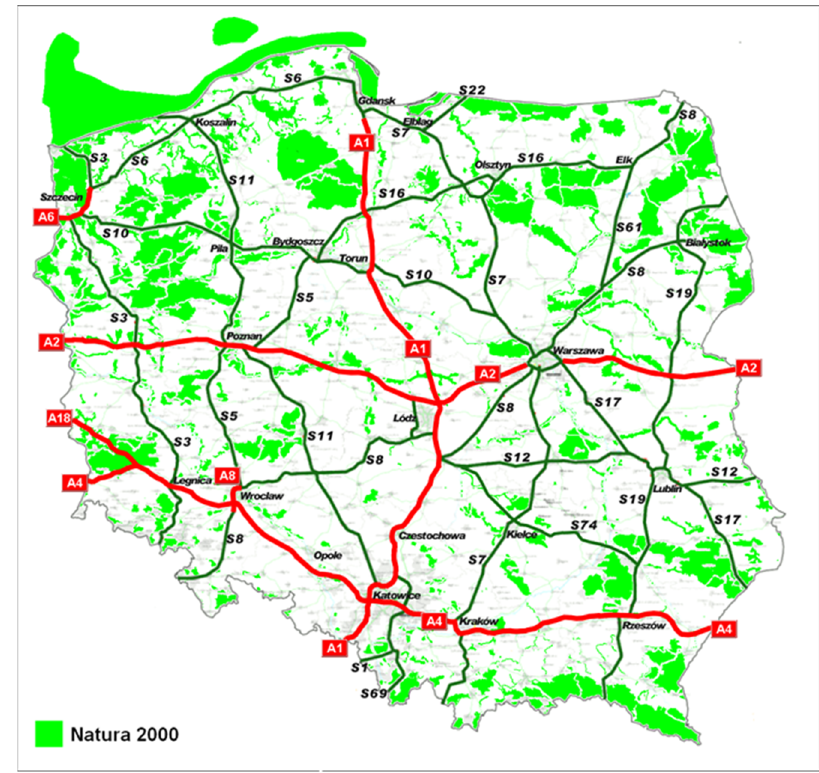
Figure 11. Natura 2000 protected areas in Poland.